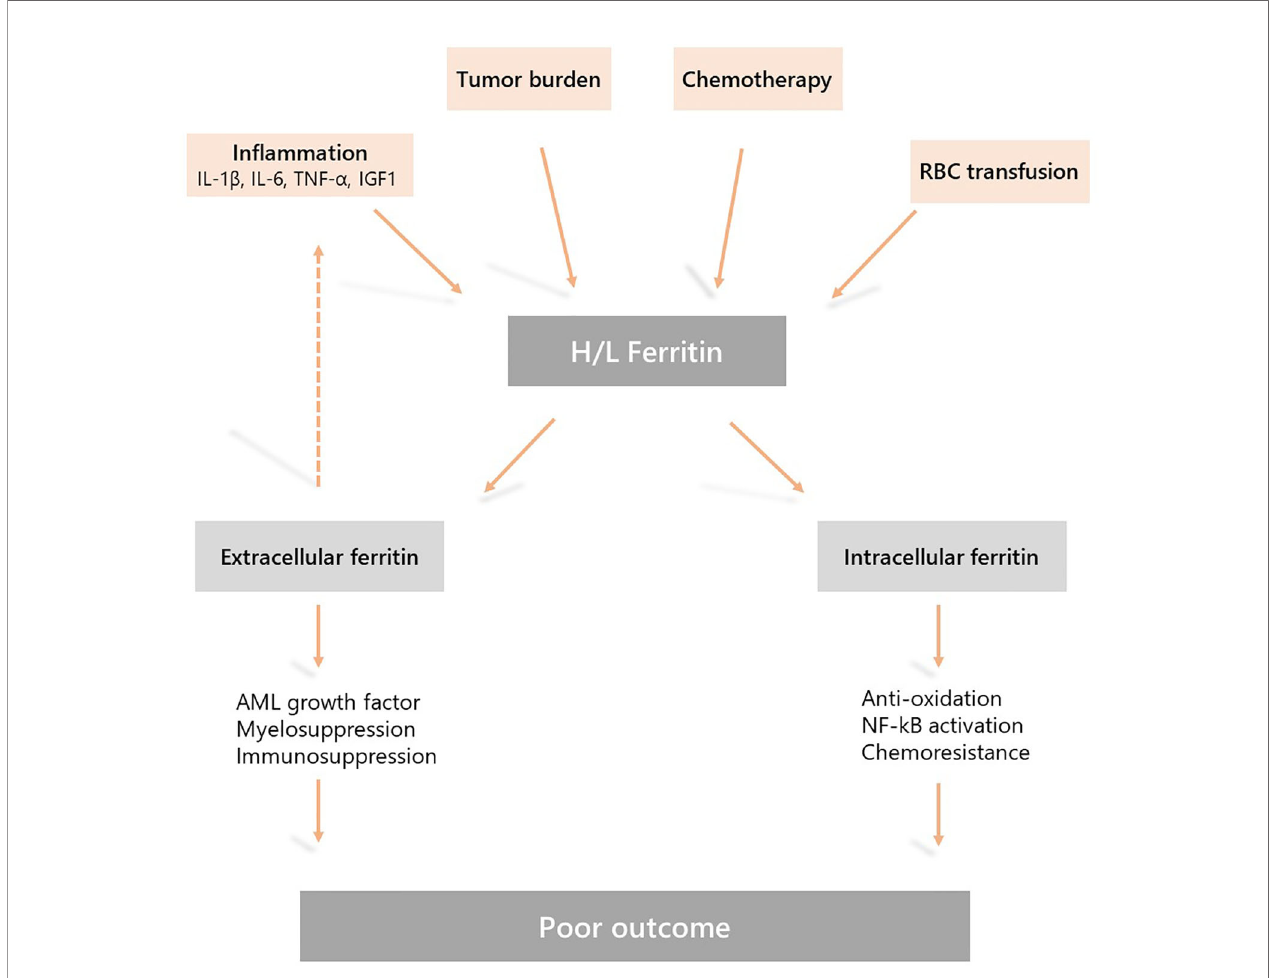
FIGURE 1 | Mechanisms underlying hyperferritinemia in acute myeloid leukemia (AML) and the role of ferritin in AML physiopathology. Elevated serum ferritin levels are due to a dysregulated in fl ammatory response, chemotherapy, disease burden, and the release by leukemic cells. This is further sustained by iron overload due to red blood cell transfusion during induction and consolidation treatment. Extracellular and intracellular activities of ferritin may induce resistance to chemotherapy, myelosuppression and disease progression resulting in a poor